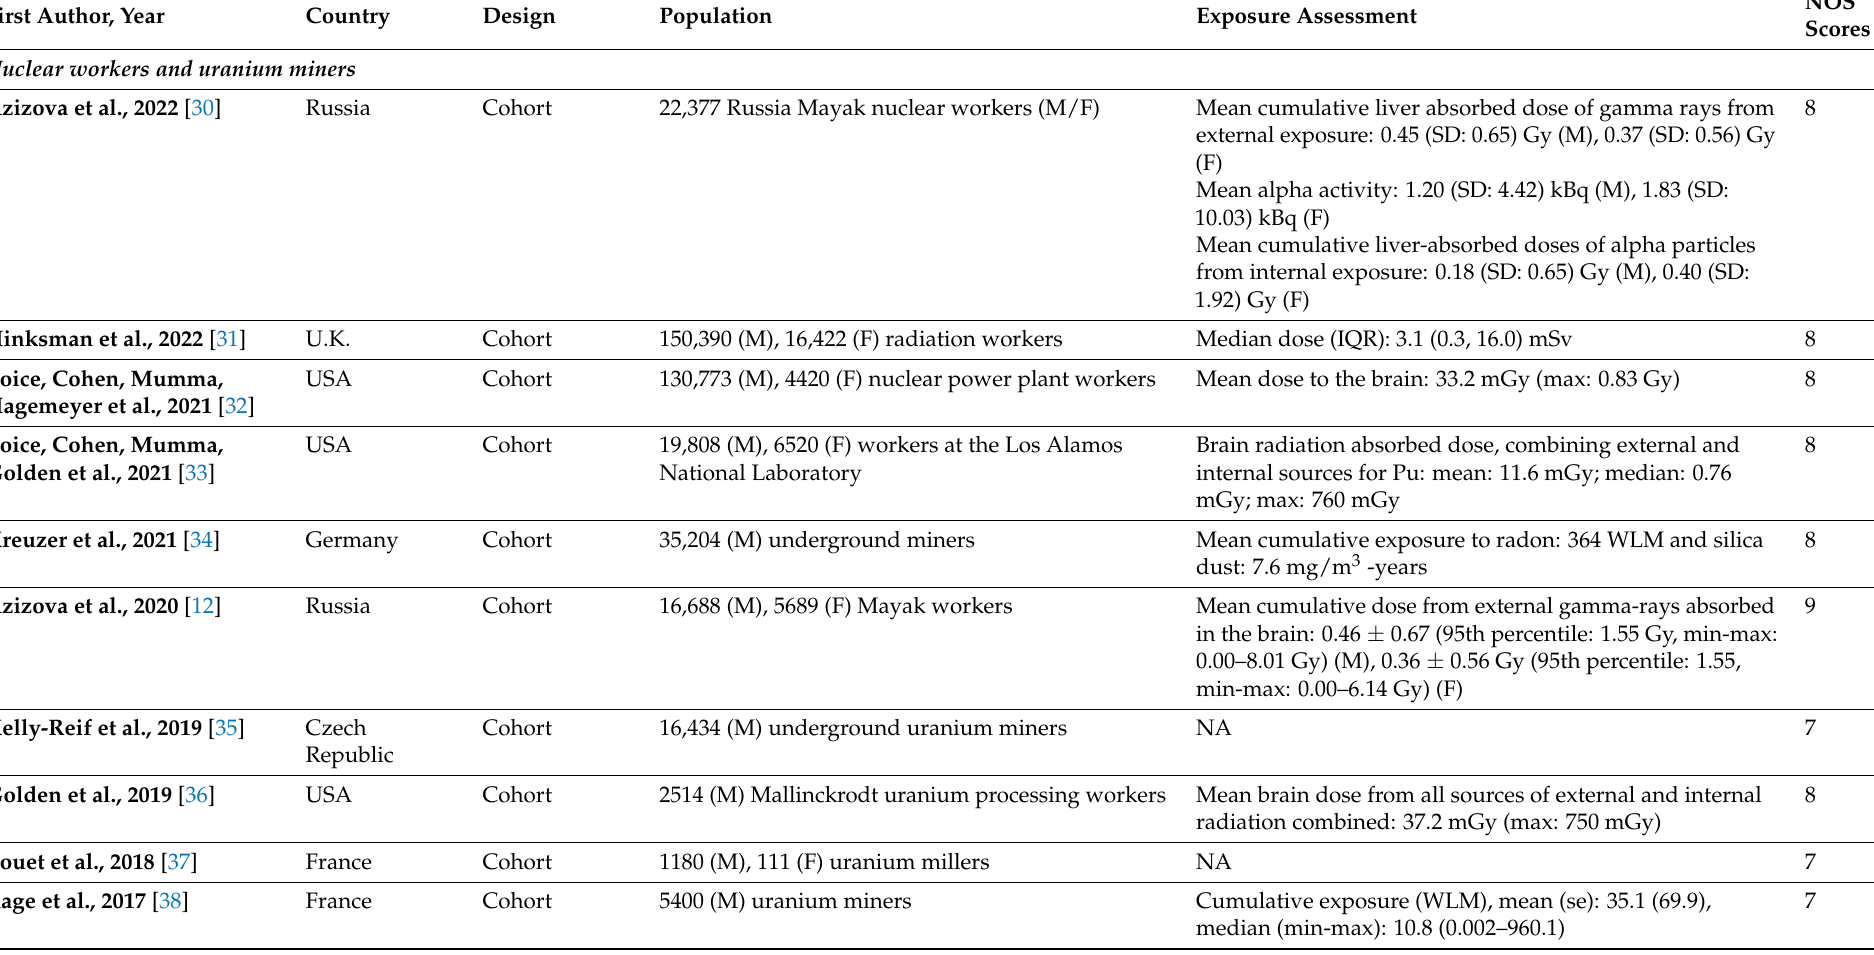
Table 1. Characteristics of the included